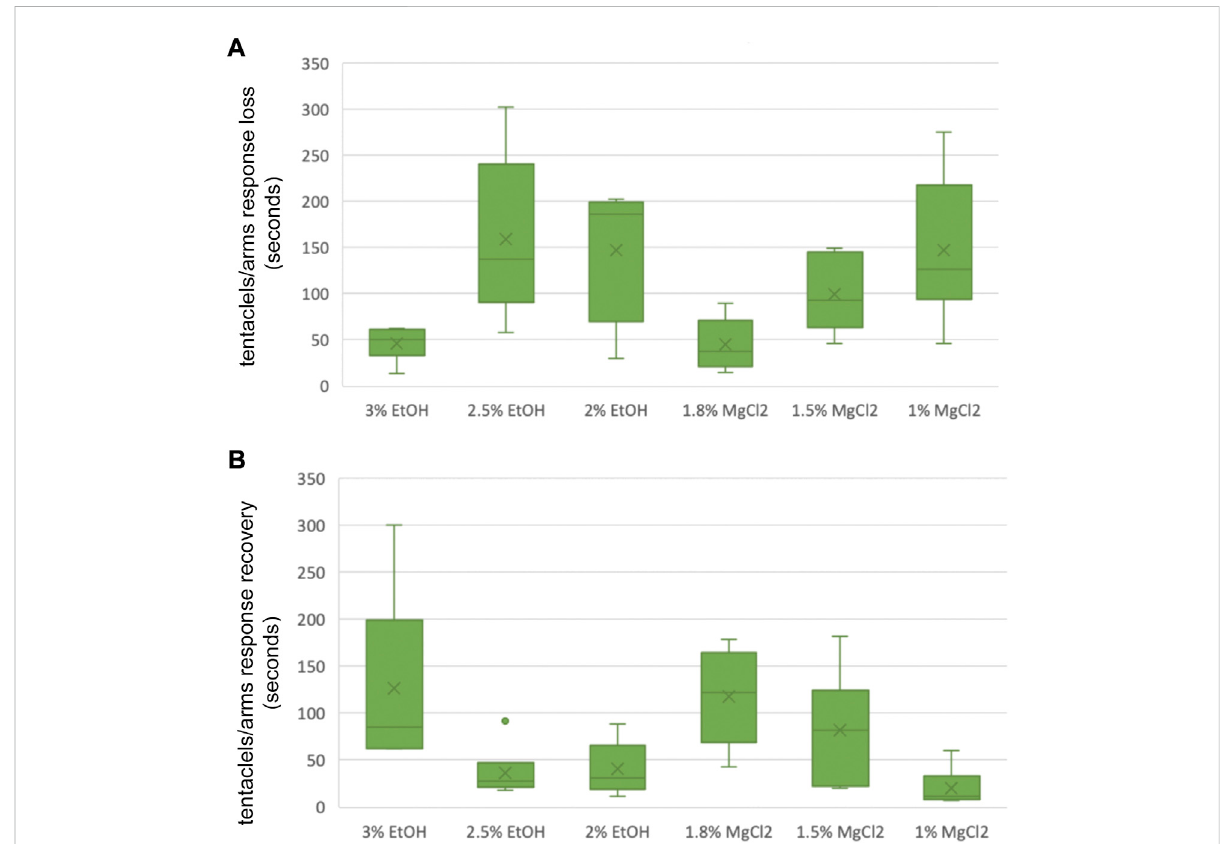
FIGURE 6 (A) Box and whiskers plot with the time until loss of tentacles/arms response in seconds. The y-axis represents the seconds until loss of tentacles/arms response and the x-axis displays the three EtOH and MgCl 2 concentrations. The upper and lower limits show the highest and the lowest times, respectively, until the loss of tentacles/arms response, and the mid-point shows the mean. (B) Box and whiskers plot with the time to recovery of tentacles/arms response in seconds. The y-axis represents the seconds to recovery of tentacles/arms response and the x-axis displaysthethreeEtOHandMgCl 2 concentrations.Theupperandlowerlimitsshowthehighestandthelowesttimes,respectively,untiltherecovery of tentacles/arms response, and the mid-point shows the